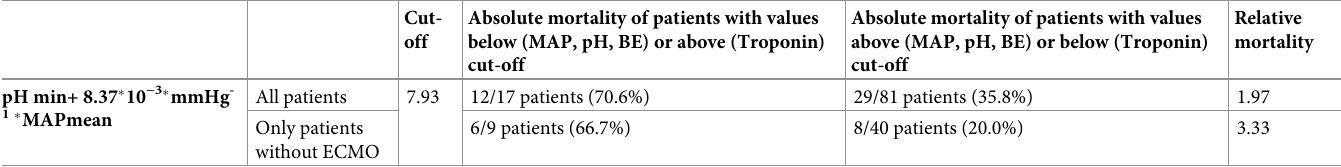
Table 2. Relative mortality in the second-wave cohort (multivariable analysis). Using the cut-off value for a survival probability of 50%, which had been determined by multivariabe regression analysis for the first-wave patients, the cohort was divided into two groups: patients with values above and patients with values below the cut-off. Mortality within the groups and, from these results, the relative mortality was calculated. pHmin, minimum pH of blood during the 14-day observation period for each patient; MAPmean, mean MAP during the 14-day observation period for each